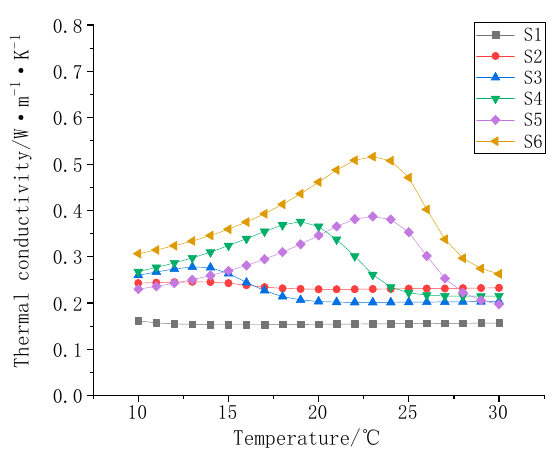
Figure 12. Thermal conductivity of S1–S7.